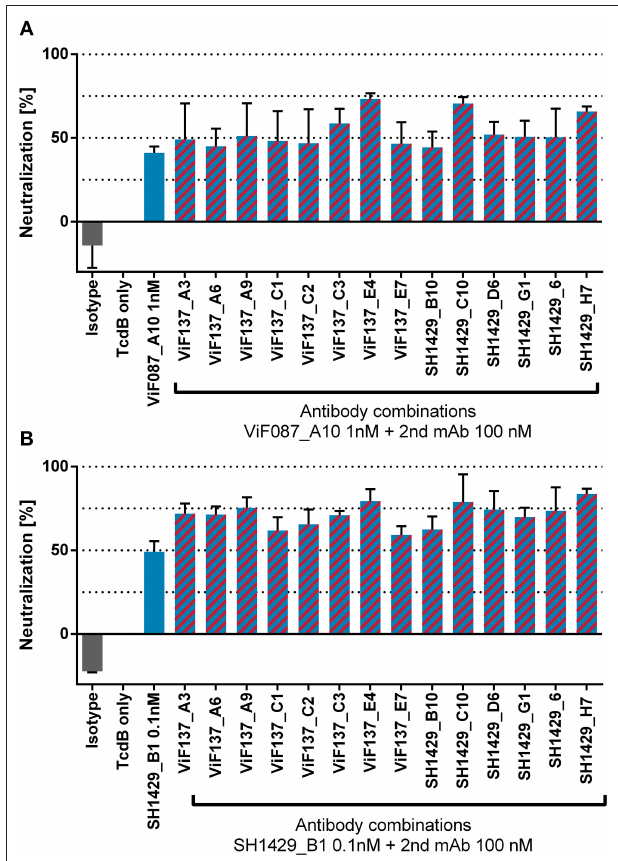
FIGURE 4 | In vitro neutralization of TcdB with antibody combinations. TcdB (0.1 pM) and either 1nM of ViF087_A10 (A) or 0.1nM SH1429_B1 (B) mAbs were coincubated in cultivation media with 100nM of CROPs binding